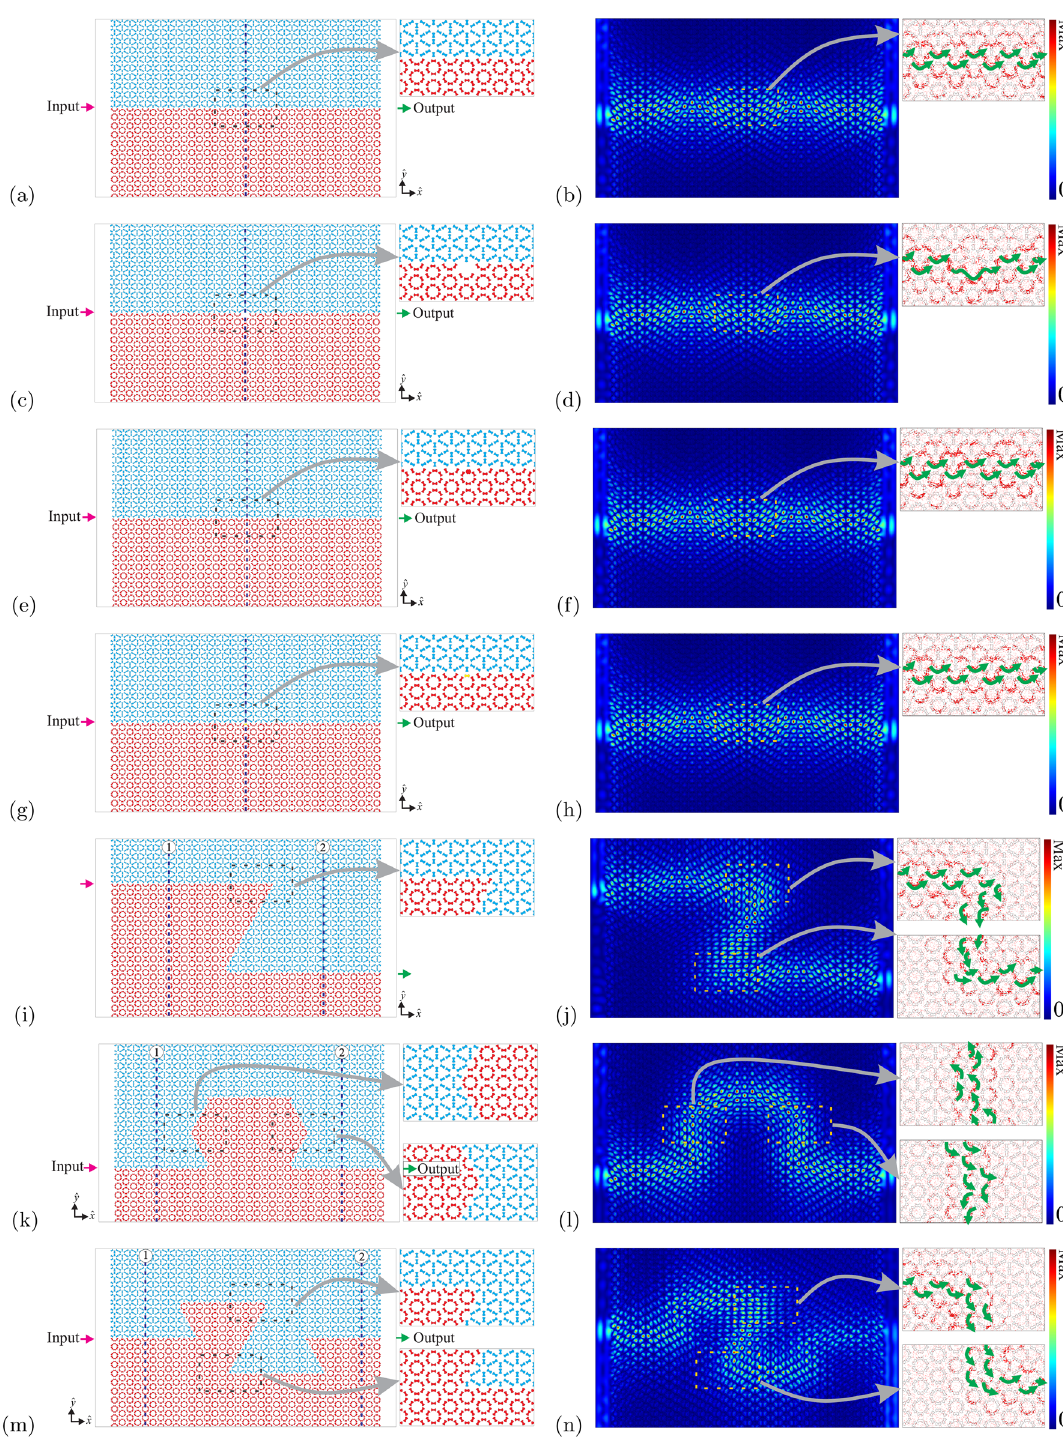
Figure 8. Simulation of the propagation of light along the photonic structure. Schematic for ( a ) interface between trivial and topological photonic crystals without defect, ( c ) interface with cavity defect, ( e ) interface with a larger rod, ( g ) interface with an Al rod, ( i ) Z interface, ( k ) Omega interface and ( m ) double horseshoe interface. The source of light is on the left and a detector is on the right. In all cases φ respectively. Spatial distribution of the normalised electric field E N with ω a /( 2 π c ) without defect, ( d ) interface with cavity defect, ( f ) interface with a larger rod, ( h ) interface with an Al rod, ( j ) Z interface, ( l ) Omega interface and ( n ) double horseshoe interface. The Poynting vector directions are illustrated by the arrows. (We used COMSOL Multiphysics v.6.0. www. comsol. com. sofware to create the